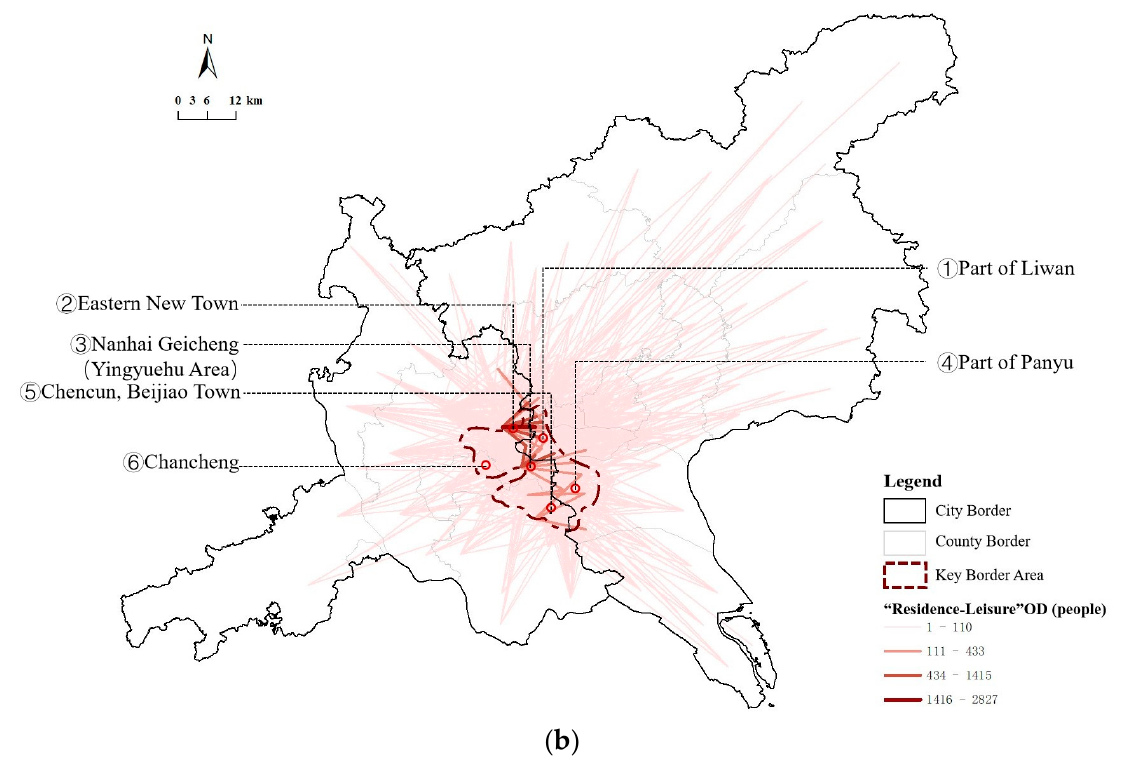
Figure 7. “Residence-Leisure” OD travel streamline of 2019. ( a ) The starting point (o) is in the border area; ( b ) The terminus (d) is in the boundary area.